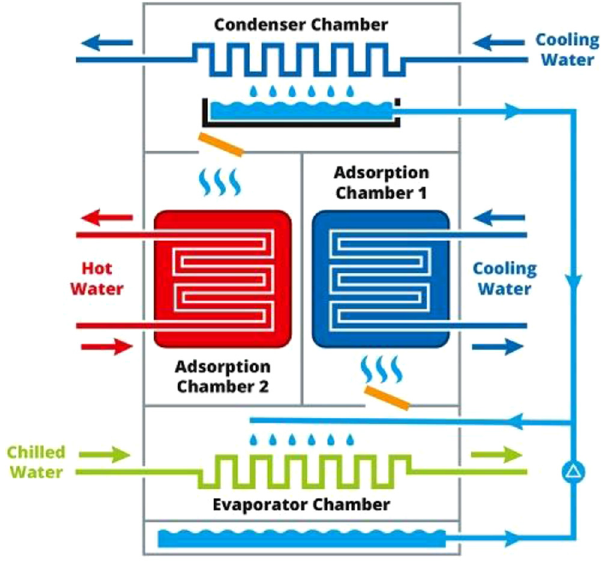
Fig. 1. Working principle of an adsorption chiller. Source